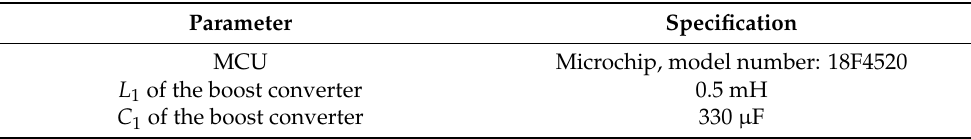
Figure 11. Architecture diagram of the solar photovoltaic simulator connected with the boost converter and embeds the proposed control strategy. Table 4. The specification of the boost converter and the MCU.